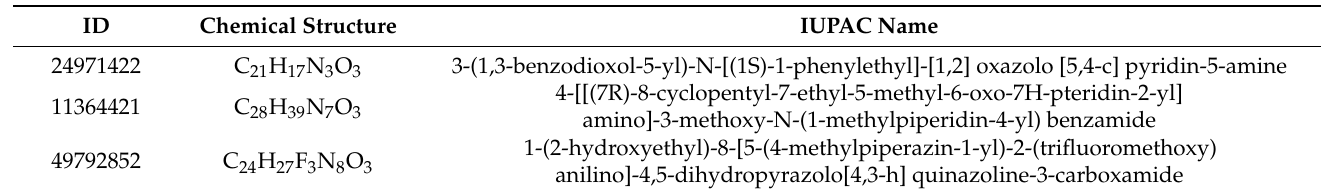
Table 1. Chemical structure and ID according to CMap for PLK2